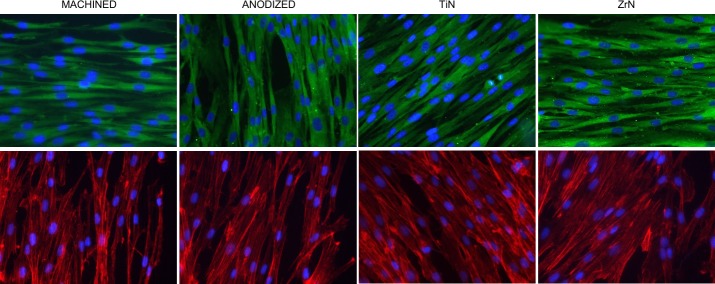
IF analysis.IF staining of HGFs grown on Ti disks for 14 days. Upper panels display staining of vinculin (in green); lower panels show labeling of actin filaments by Phalloidin (in red). For both panels, nuclei are stained blue. Images taken at 40x magnification.